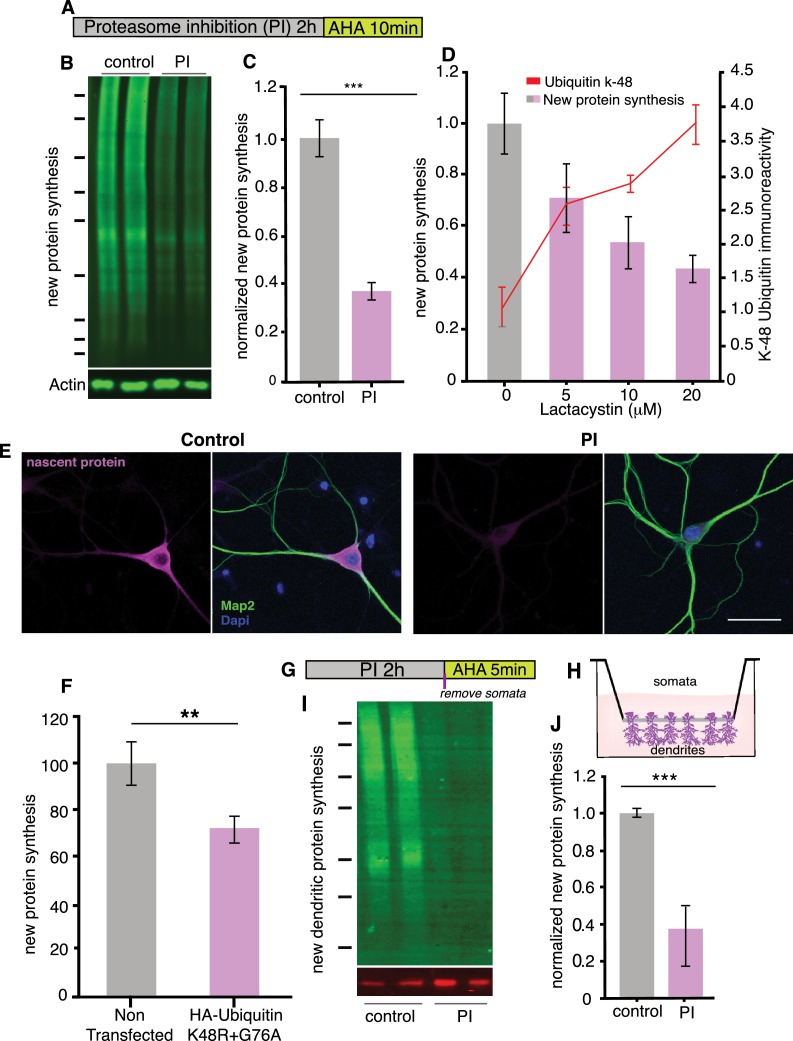
Proteasome inhibition leads to a coordinate inhibition of protein synthesis in neurons.(A) Scheme indicating experimental protocol: cultured hippocampal neurons were exposed to a proteasome inhibitor (PI; MG132 or lactacystin- see supplementary figs) for 2 hr and then the non-canonical amino acid AHA was added for 10 min to label newly synthesized proteins (see Materials and methods). (B) Representative BONCAT western blot using an anti-biotin antibody to detect newly synthesized proteins (labeled with AHA and then clicked with a biotin alkyne tag). Shown are two biological replicates each from a control sample (not treated with a PI) and a PI-treated sample, respectively. (C) Analysis of experiment shown in B. Protein synthesis in hippocampal neurons was significantly reduced following proteasome inhibition. p<0.001, unpaired t-test, three experiments. Error bars = SD. (D) Analysis of newly synthesized proteins (puromycylation; bar graphs) and K48 ubiquitin chains (line graph) after treatment of cultured neurons with 5, 10 or 20 μM Lactacystin. t-Test (multiple comparisons) n = 4 experiments for each concentration. For protein synthesis, 0 vs 5 μM p<0.05, 0 vs 10 μM p <0.01, 0 vs 20 μM p<0.01, For K48 ubiquitin, 0 vs 5 μM p<0.01, 0 vs 10 μM p <0.001, 0 vs 20 μM p<0.01. (E) Metabolic labeling (magenta; using puromycylation, see Materials and methods) of the global nascent protein pool in hippocampal cell bodies and dendrites following proteasome inhibition, nucleus (DAPI, blue) and dendrites (MAP2, green) can also be visualized in the images. Scale bar = 50 microns. (F) Analysis of protein synthesis (using puromycylation) of the global nascent protein pool in hippocampal neurons transfected with HA-Ubiquitin K48R+G76A –see Figure 1—figure supplement 2, (unpaired t-tests p<0.01, three experiments, n = 110 mock n = 105 ubi-K48R+G76A-transfected neurons). (G) Scheme of experiment to determine whether dendritic protein synthesis is also altered, neurons were treated with PI and labeled with AHA for the last 5 min. (H) Scheme of the experimental set up, neurons were cultured on a special membrane that allows dendrites and axons, but not cell bodies, to grow through pores. The proteasome was inhibited, then the cell bodies were scraped away from the top of the membrane and metabolic labeling was conducted on the dendritic fraction. (I) Inhibition of the proteasome results in a coordinate inhibition of dendritic protein synthesis. Representative BONCAT western blot showing the metabolically labeled newly synthesized dendritic protein in green. (J) Analysis of experiment shown in (I). Protein synthesis in dendrites was significantly reduced by over 60% following proteasome blockade, (p<0.001, unpaired t-test, four experiments) Error bars = SEM. Molecular weight markers in B and G from top-to-bottom are 250, 150, 100, 75, 50, 37, and 25 kD.Figure 1—source data 1.Source data for Figure 1A and G.Figure 1—source data 2.Source data for Figure 1C, D, F, J.